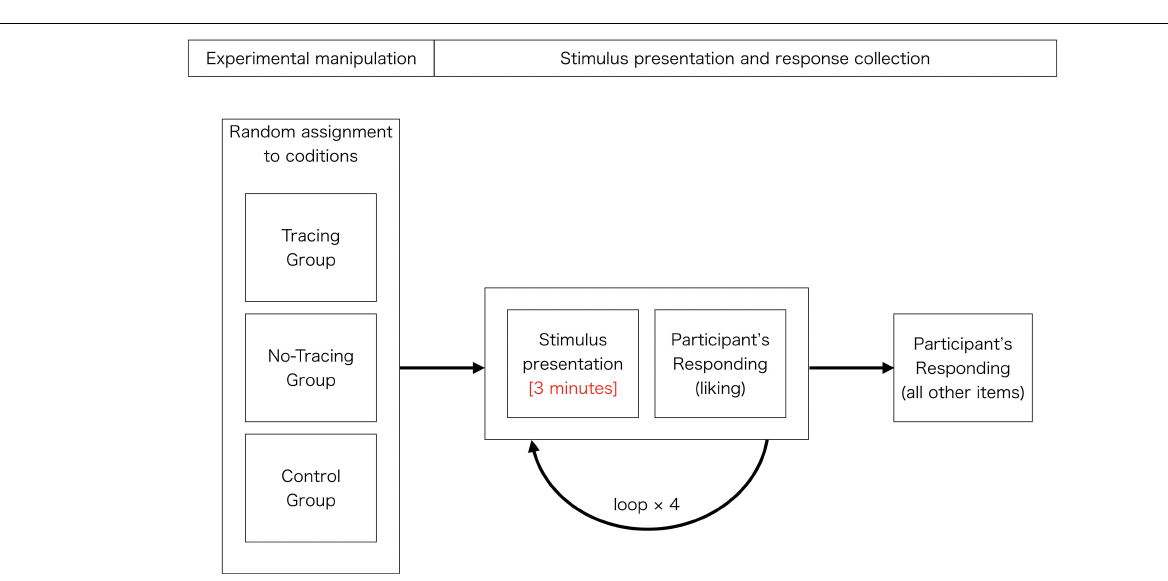
FIGURE 1 | The four calligraphy works used as stimuli (with printed font).